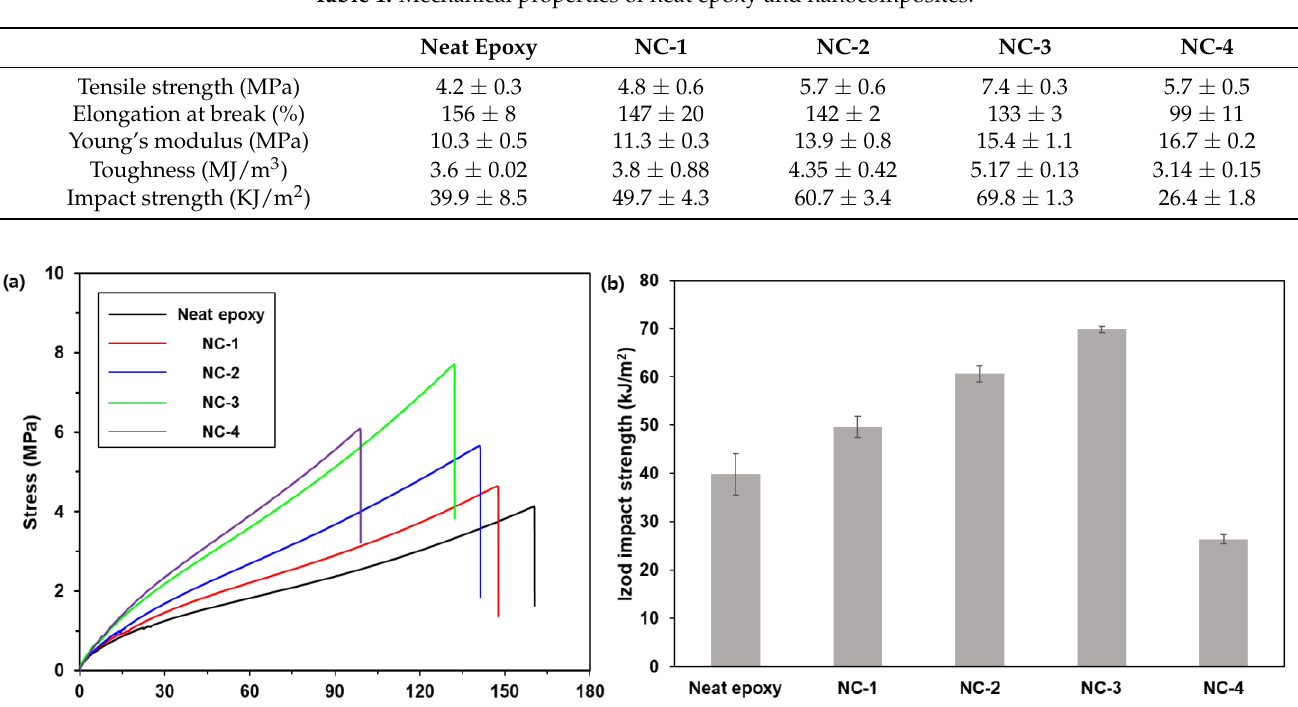
Figure 6. ( a ) Stress-strain curves of neat epoxy and nanocomposites and ( b ) Izod impact strength of nanocomposites.